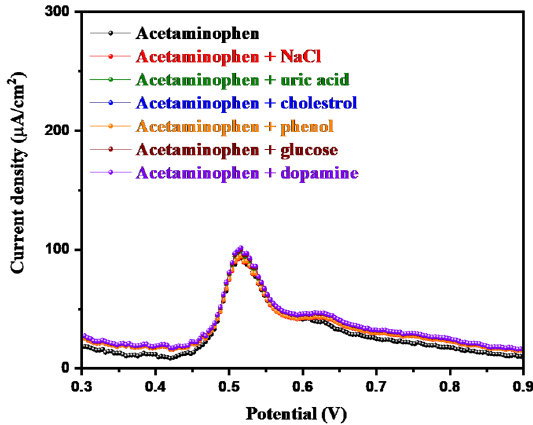
Figure 9. DPV pattern of S@rGO/GCE in presence of 100 µM acetaminophen and 100 µM acetaminophen + interfering species in 0.1 M PBS (pH = 7.0; scan rate = 50 mV/s).